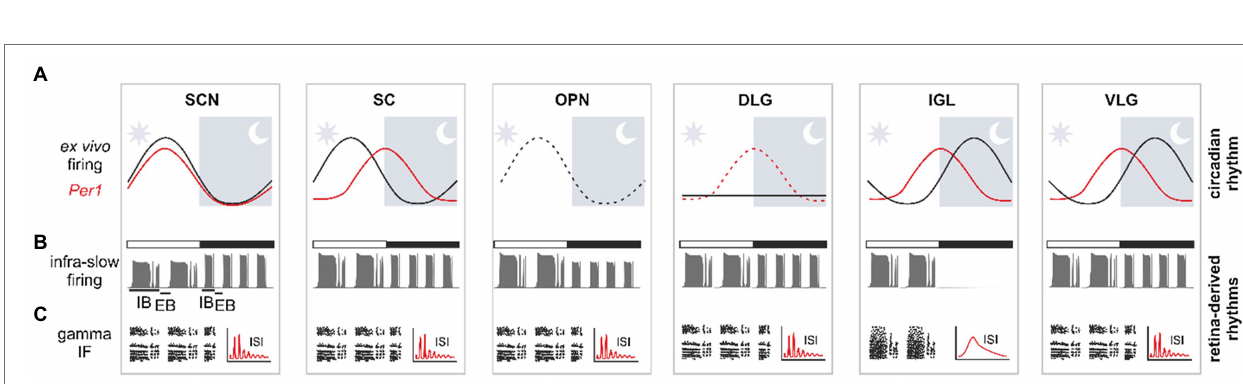
FIGURE 1 | The functional neuroanatomy of the subcortical visual system (SVS). Red colouring denotes retinorecipient areas of the SVS. Black lines show neuronal connections among SVS nuclei, with arrows indicating the direction of connectivity. SC, superior colliculus; OPN, olivary pretectal nucleus; SCN, suprachiasmatic nucleus of the hypothalamus; DLG, dorsolateral geniculate; IGL, intergeniculate leaflet; VLG, ventrolateral geniculate; opt, optic tract; GHT, geniculo-hypothalamic tract; och, optic chiasm.